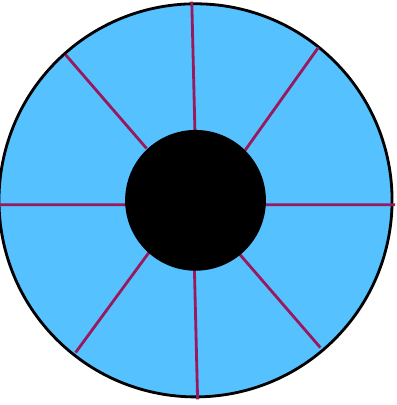
Figure 4 . A maximal thread configuration connects the CFT boundary to the blackhole horizon where it saturates.